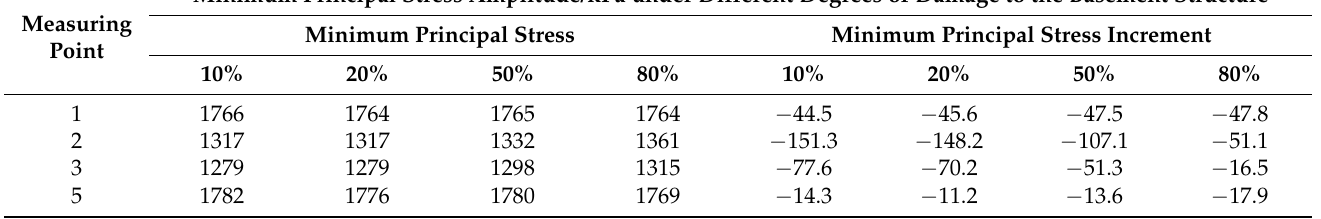
Table 18. Minimum principal stress amplitude of measuring points 1, 2, 3, and 5 under different degrees of damage to the basement structure.